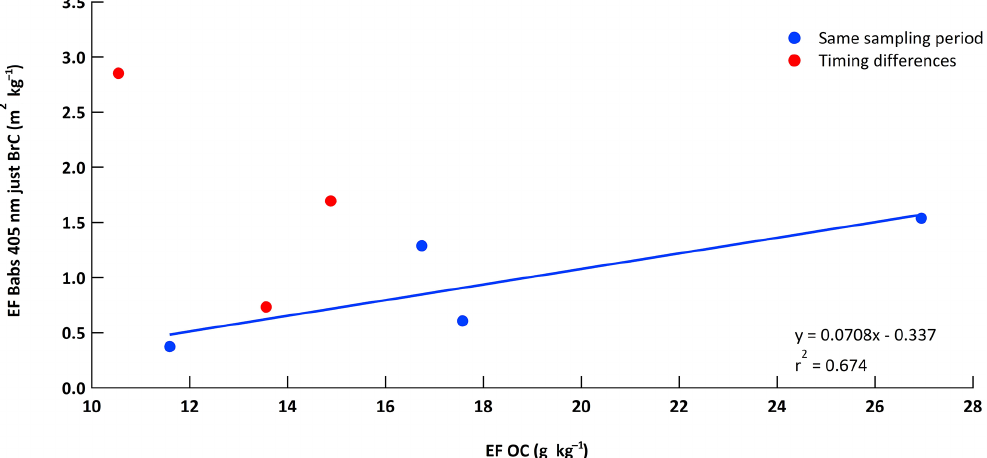
Figure 6. The estimated mass absorption coefficient of the bulk OC from the B abs assigned to BrC vs. simultaneously measured OC mass on filters. Only four plumes were sampled by both techniques over the exact same time period (blue symbols) and they were used in fit shown to estimate the